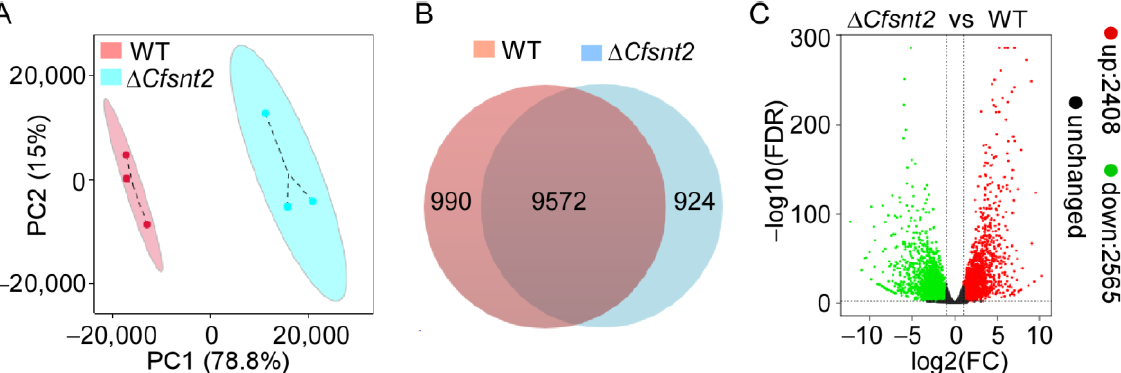
Figure 2. Transcriptomic analysis of the WT and Δ Cfsnt2 mutant. ( A ) Principal component analysis (PCA) of WT and Δ Cfsnt2 mutant. ( B ) Global view of expressed genes in WT and Δ Cfsnt2 mutant. ( C ) Volcano plot of DEGs between WT and Δ Cfsnt2 mutant. Red dots indicate upregulated genes; green dots indicate downregulated genes; black dots indicate unchanged genes.